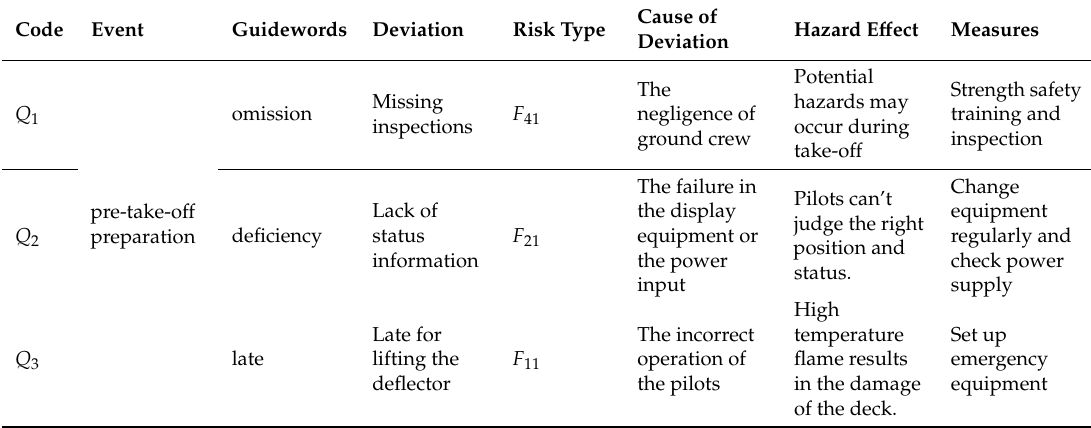
Table A1. The improved HAZOP analysis (in